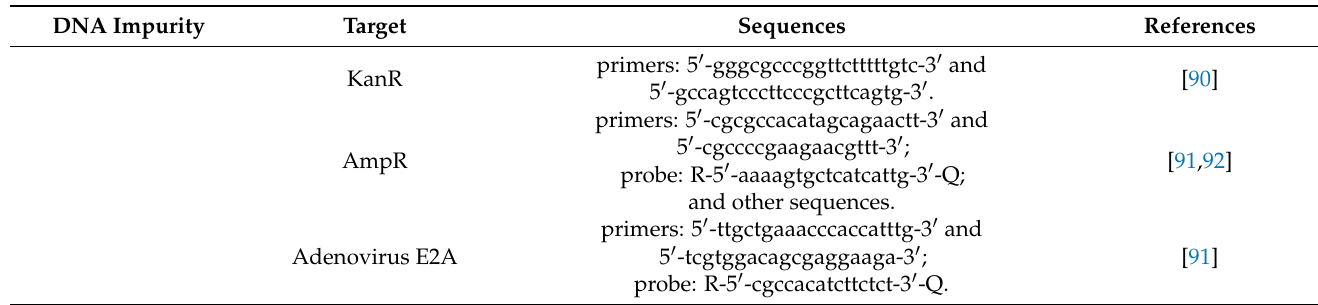
Table 2. Published primers and probes for contaminating DNA assessment. DNA